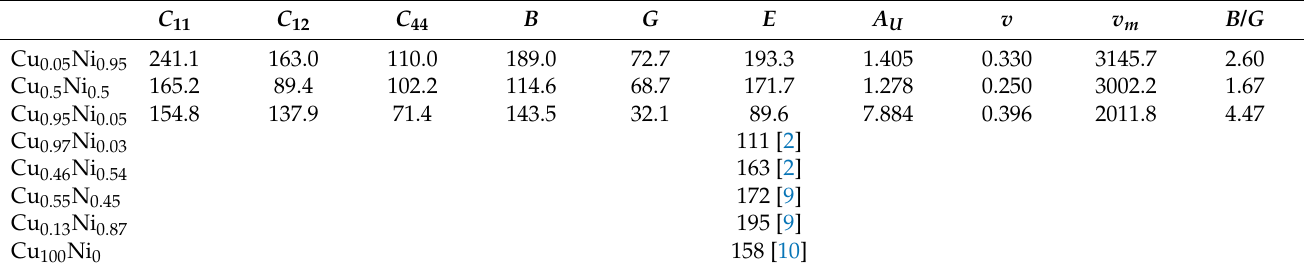
Table 2. Calculated mechanical properties of Cu–Ni alloys, C ρσ is elastic constant, B is bulk modulus, G is shear modulus, v m is average velocity, E is Young’s modulus, and v is Poisson’s